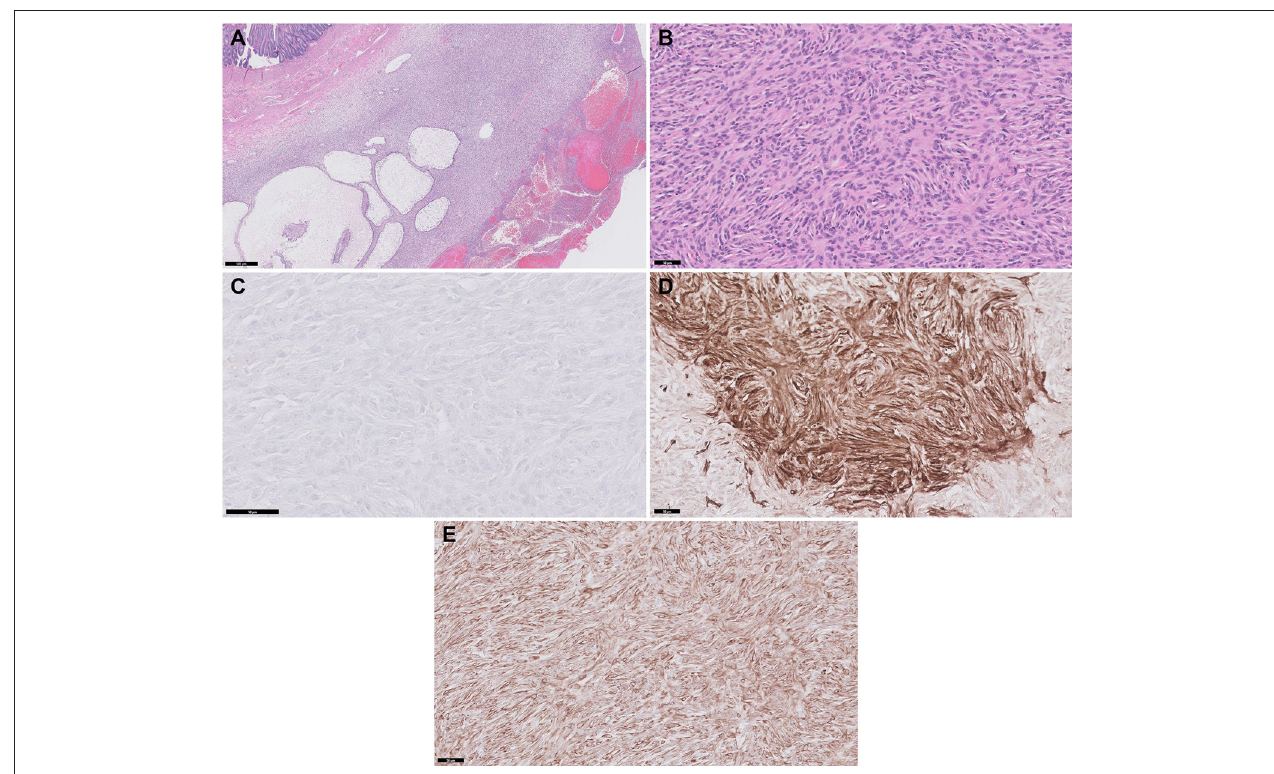
FIGURE 4 | Histopathology and immunohistochemistry (IHC) of the jejunal mass. (A) The spindloid neoplastic cells are haphazardly arranged in short bundles and streams with multiple pseudocystic structures. HE stain, Bar, 500 µ m. (B) The neoplasm is composed of spindle cells with indistinct cell borders, wispy eosinophilic cytoplasm and oval nucleoli. HE stain, Bar, 50 µ m. (C) Neoplastic cells demonstrate negative labeling with CD117. IHC, DAB chromogen, Bar, 50 µ m. (D) Neoplastic cells show strong cytoplasmic labeling with Smooth muscle actin. IHC, DAB chromogen, Bar, 50 µ m. (E) Neoplastic cells show strong cytoplasmic labeling with Desmin. IHC, DAB chromogen, Bar, 50 µ